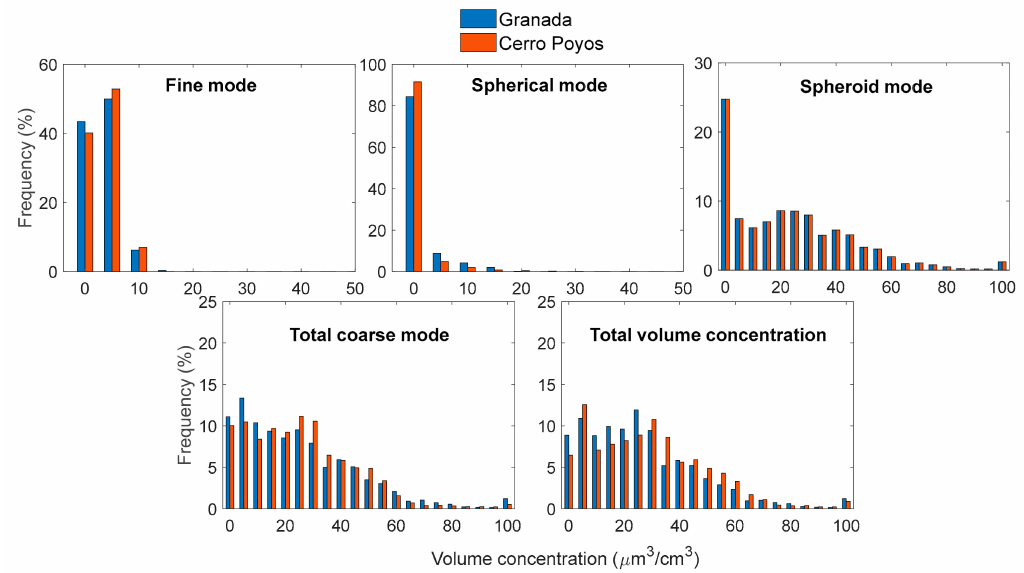
Figure 4. Frequency distribution of the volume concentration for every mode, the total coarse mode and the total volume concentration for summer 2012. Each point of the 15-m vertically resolved profiles was considered as independet to retrieve the frequency distributions. In the retrievals from Granada station, only those data corresponding to heights above 1820 m a.s.l. were considered for comparison with the retrievals from Cerro Poyos.